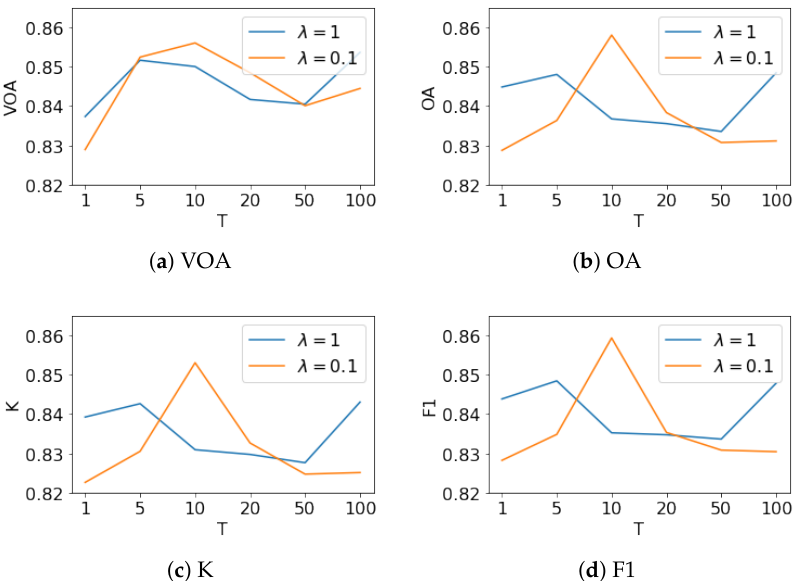
Figure 5. KD training results of different temperature and λ on AID dataset. These four subfigures demonstrated the relationship between four metrics and the temperature T , according to Table 3.